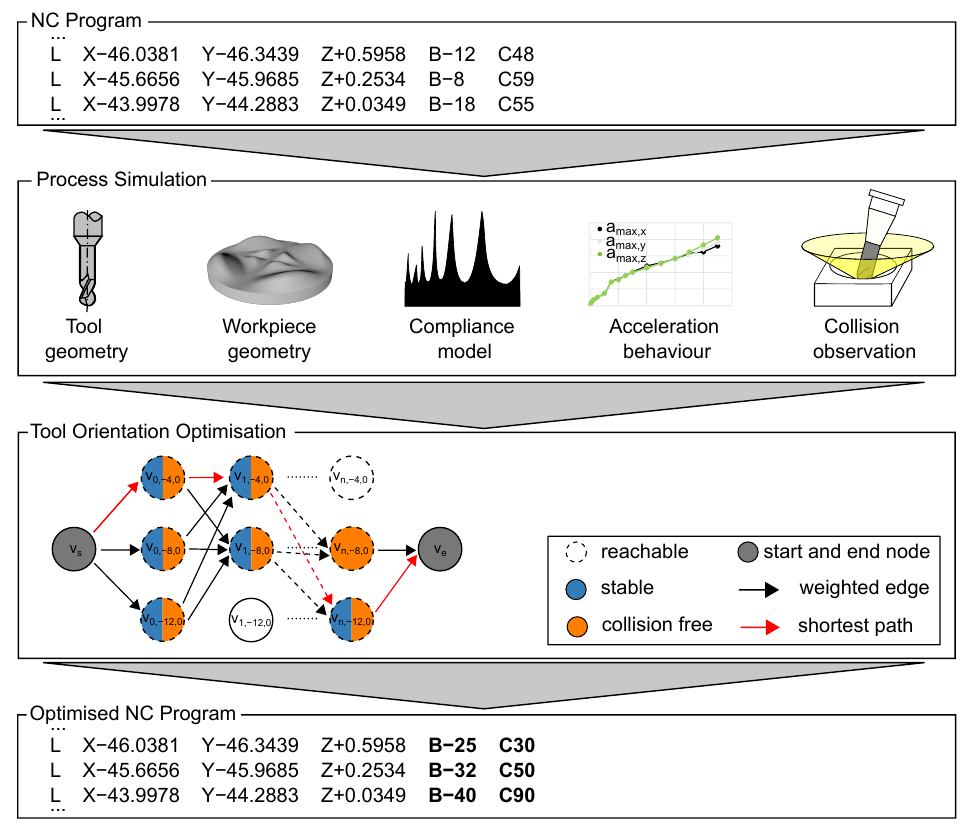
Figure 6. Approach for process stability optimisation using tilt angle-dependent compliance